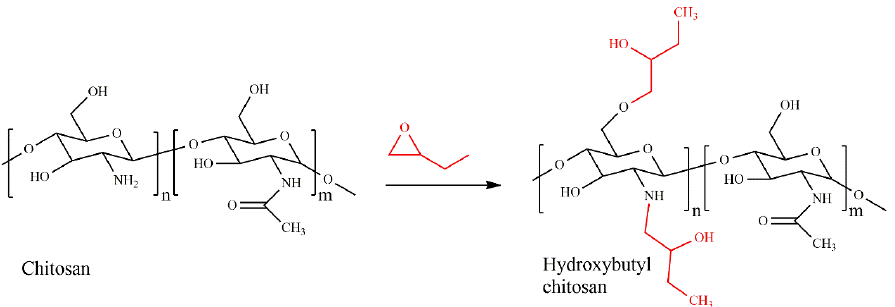
Figure 2. Synthesis of hydroxybutyl chitosan.